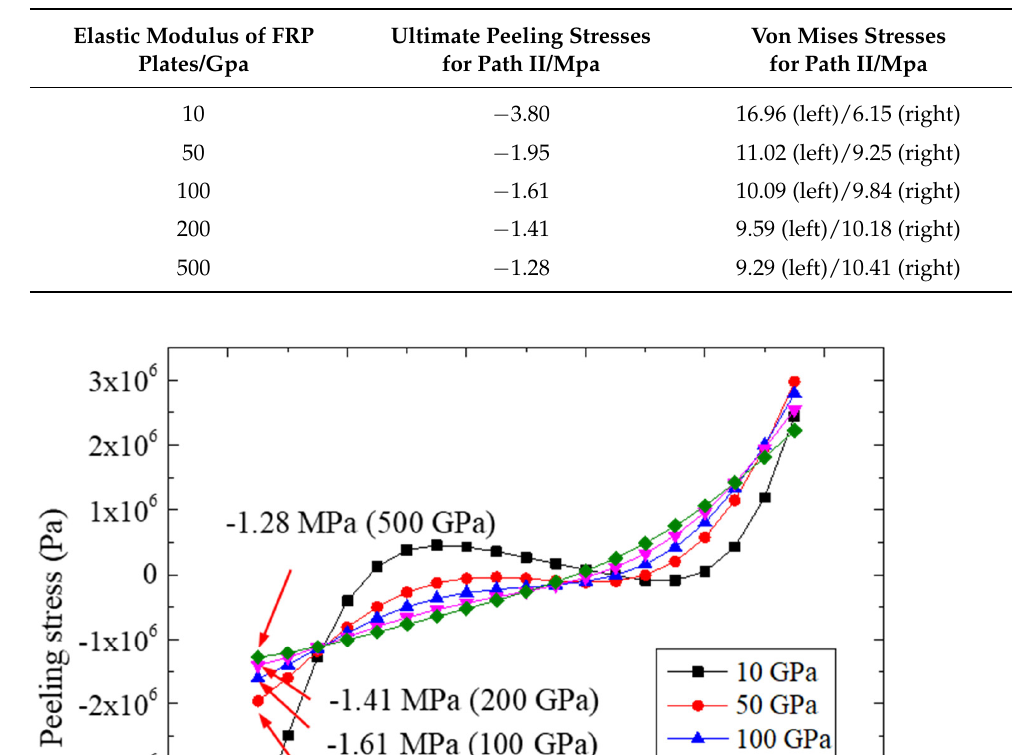
Table 2. Stress analysis results for five elastic moduli.